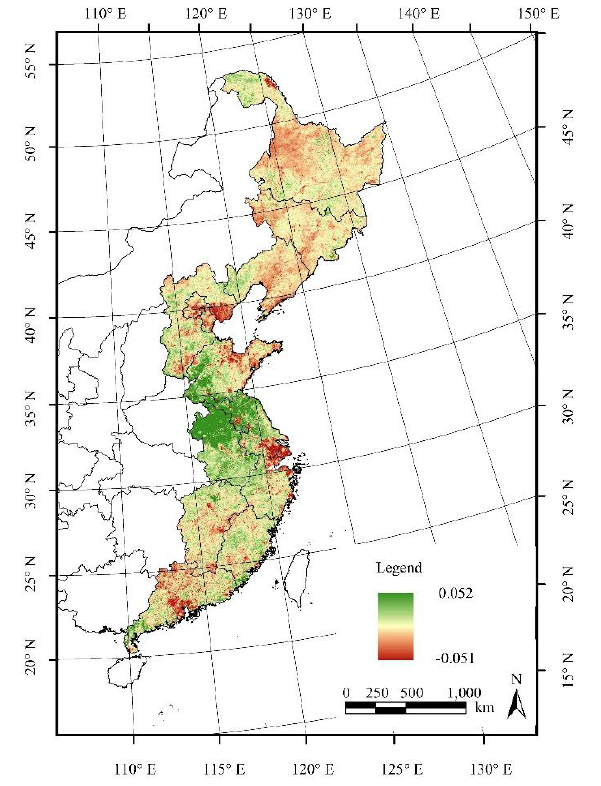
Figure 4. Vegetation change trends in Eastern China during